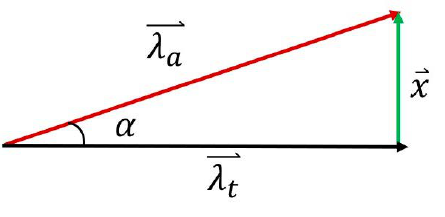
Figure 4. Diagram depicting typical layout for apparent wavelength vector ( seismic line that is “ α ” degrees oblique to the true wavelength vector ( extensional rift